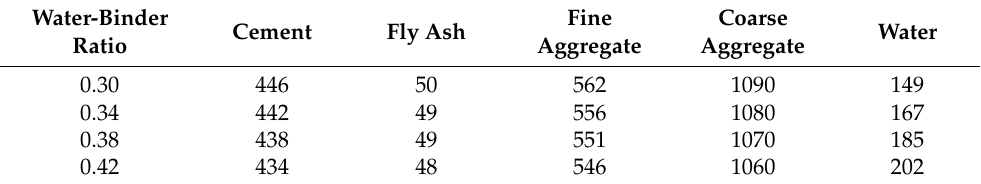
Table 7. The consumption of each mix proportion in the single-factor test (kg/m 3 ).